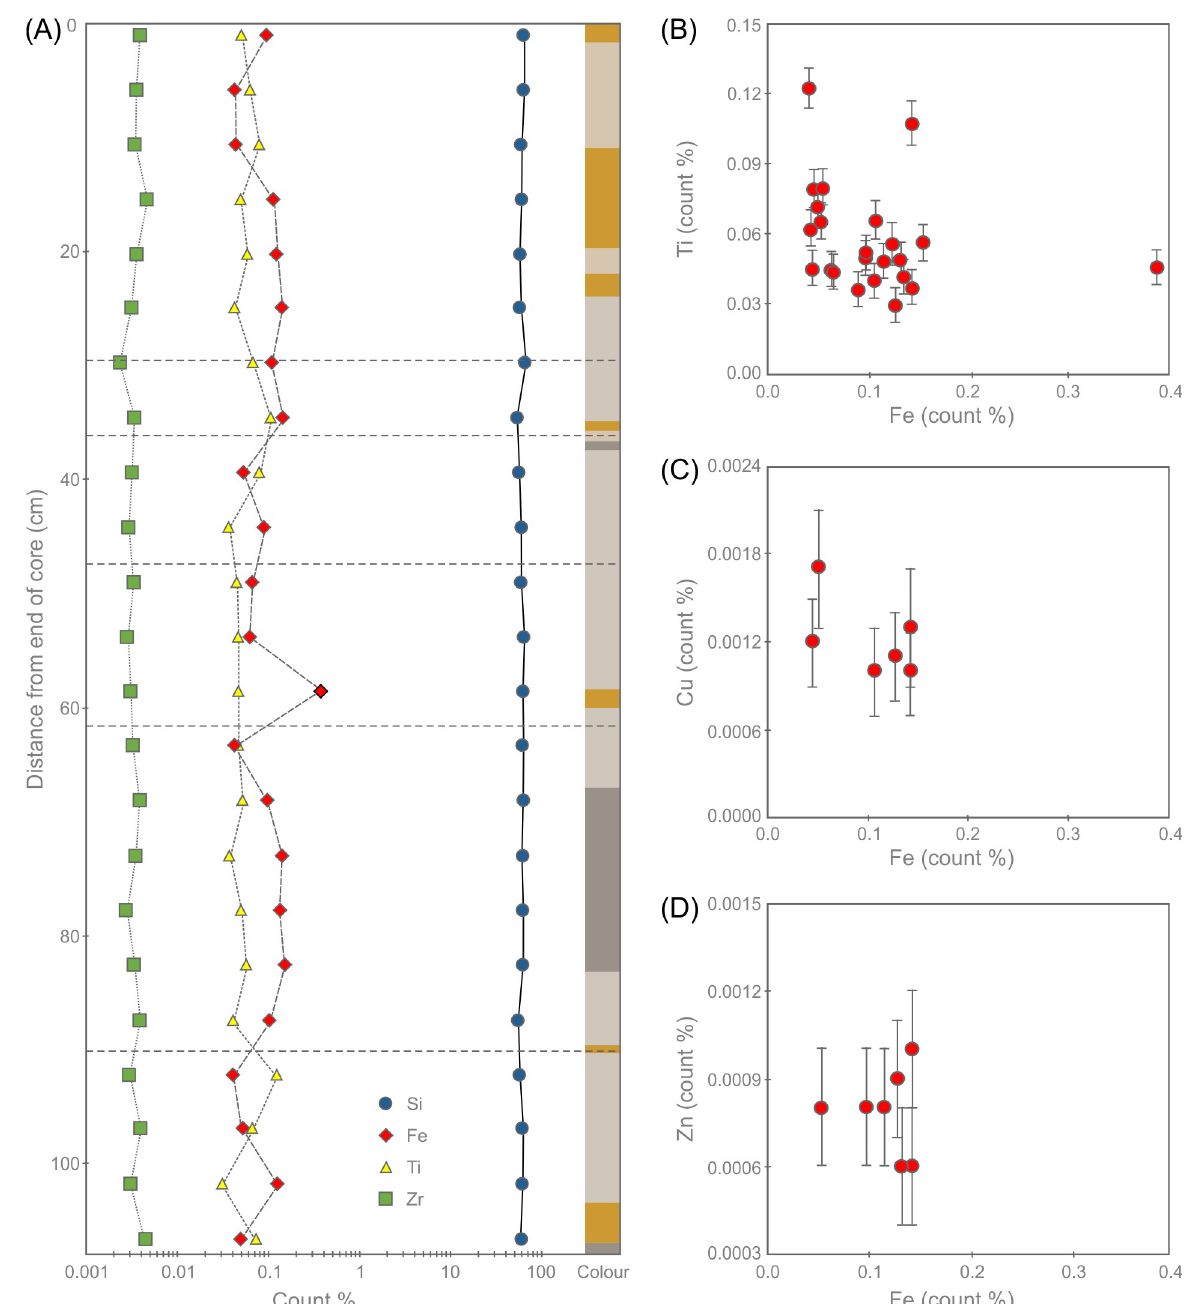
Fig 15. Portable XRF geochemical data showing (A) the variation in count % of selected elements and indicative Munsell colour along the length of the Phillips’ Core from Stone 58. Fractures are indicated as dashed lines to allow cross-referencing with Fig 5. Panels (B) to (D) show the correlation between Fe count % and (B) Ti, (C) Cu and (D) Zn. Error bars in B-D indicate instrumental error. Note that the error for Fe is smaller than the symbol diameter so is not